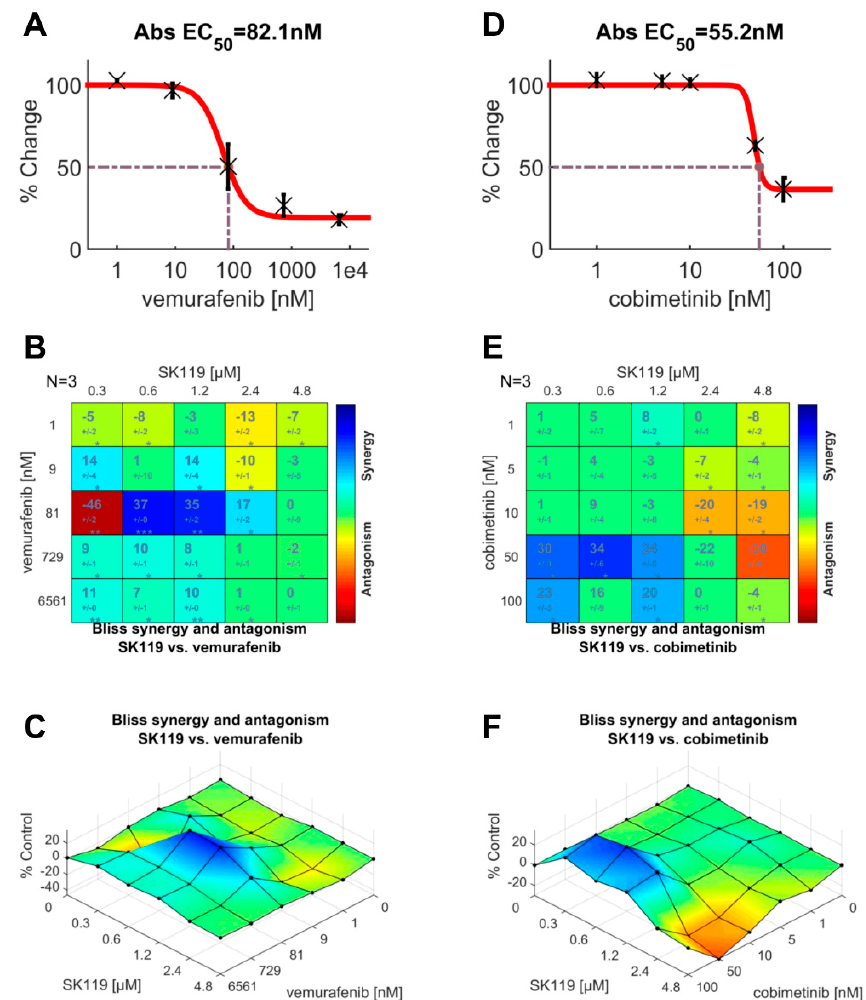
Figure 6. Treatment of WM9 and MUG-Mel2 cells with vemurafenib or cobimetinib and SK119. ( A–C ) treatment of WM9 cells with vemurafenib ( A ) or vemurafenib and SK119 in varying concentrations and analyzed using the Bliss model and the Combenefit software tool ( B , C ); ( D – F ) treatment of MUG-Mel2 cells with cobimetinib ( D ) or cobimetinib and SK119 in varying concentrations and analyzed using the Bliss model and the Combenefit software tool ( E , F ) ( n = 3, incubation time: 72 h).